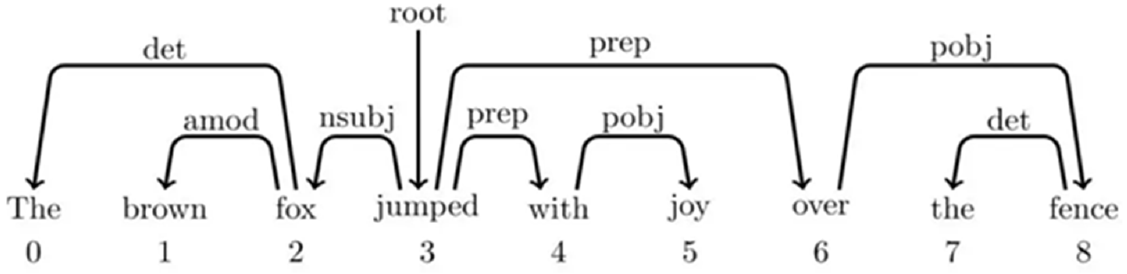
Figure 2. The example of dependency relationship.